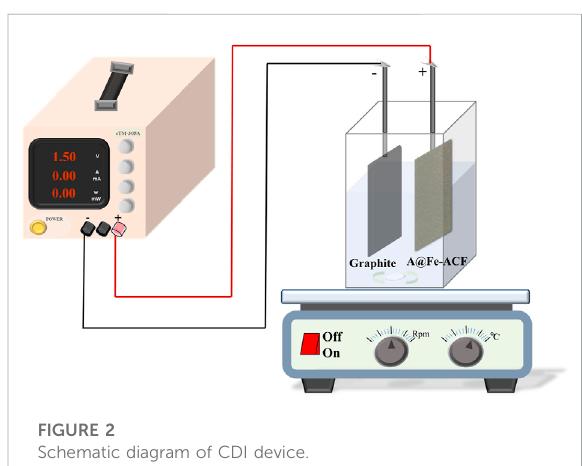
Schematic diagram of CDI